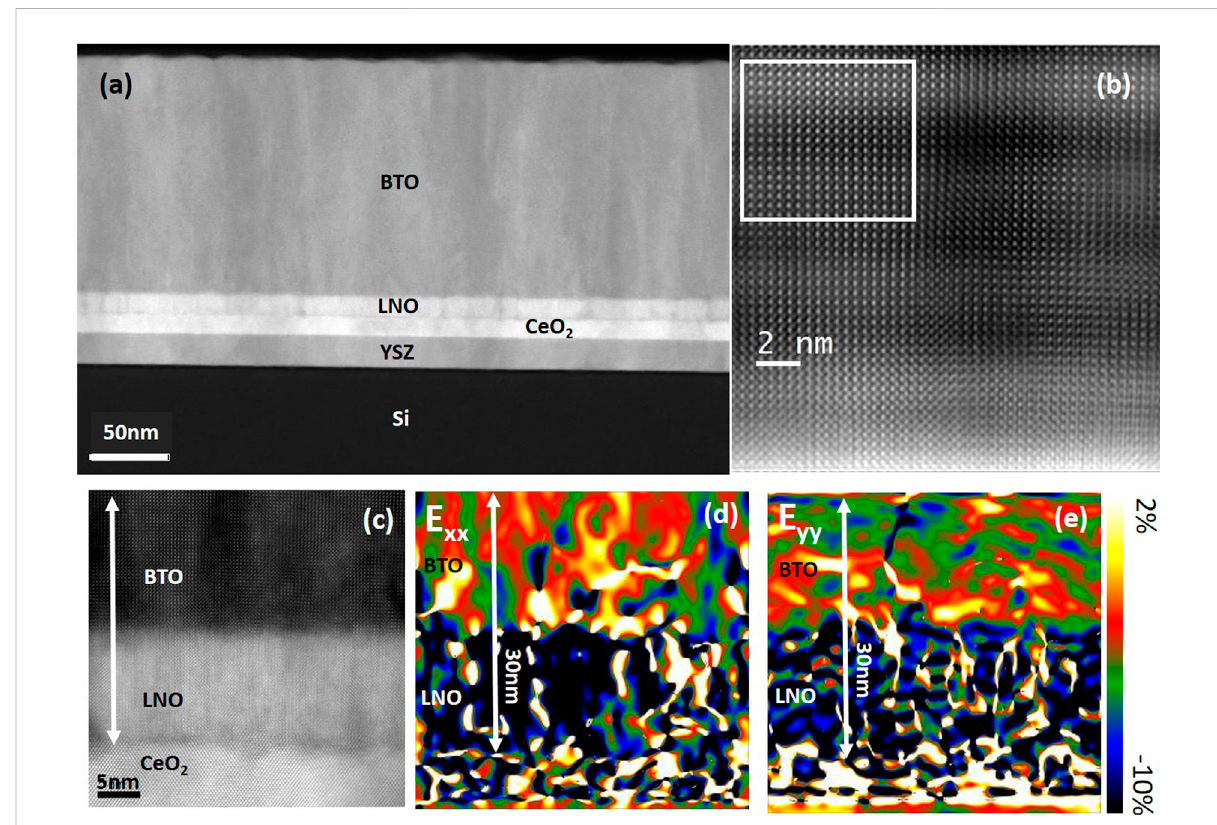
FIGURE 3 (A) Low magni fi cation STEM-HAADF cross-section corresponding to a Si(001)/YSZ/CeO 2 /LaNiO 3 /BaTiO 3 heterostructure. LaNiO 3 and BaTiO 3 arelabelledasLNOandBTO,respectively; (B)